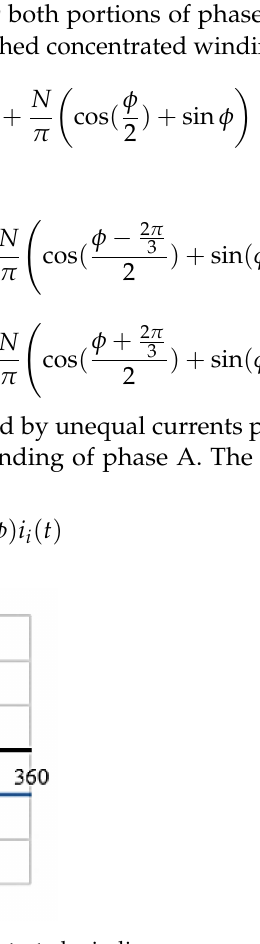
Figure 4. Phase A winding function for full pitch concentrated